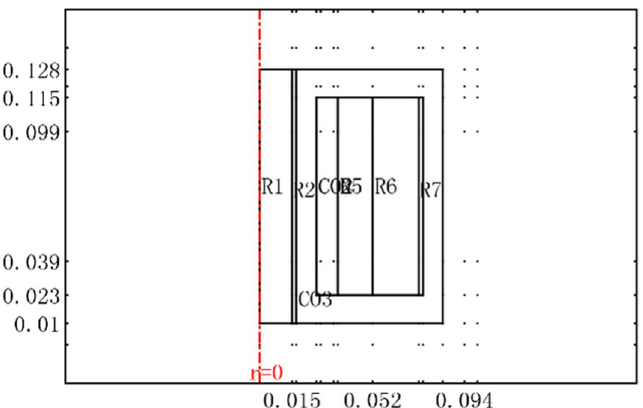
Figure 5. Thermal analysis model of the GMM smart component.